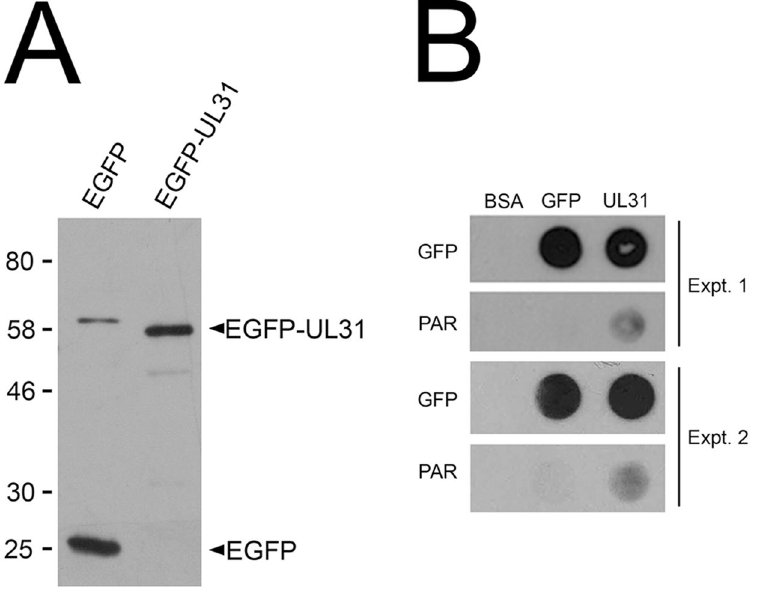
Figure 11. UL31 binds directly to PAR. ( A ) Western blot of GFP-TRAP purified EGFP and EGFP-UL31 probed with a GFP monoclonal antibody. Migration of molecular weight markers (in kDa) are shown on the left of the blot. The approximately 60 kDa species found in the EGFP lane likely represents an EGFP dimer that was not denatured prior to, or during, electrophoresis. The blot has been cropped above 80 kDa and below 25 kDa. The full length blot is provided as supplementary information. ( B ) Purified BSA, EGFP and EGFP-UL31 were spotted onto PVDF membranes in duplicate. One sample was probed for EGFP using a GFP